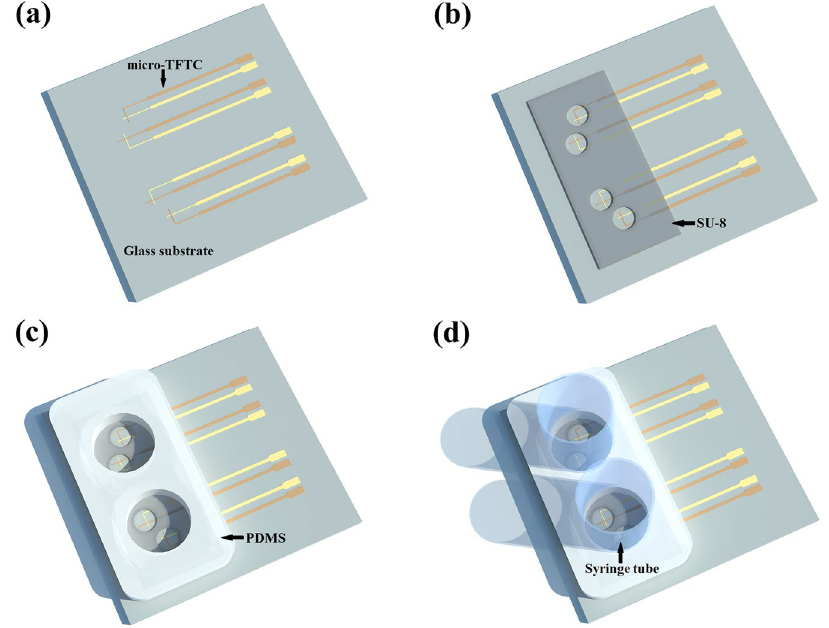
Figure 1. An illustration for the 3D structures of a testing device. ( a ) A micro-thin-film thermocouple (TFTC) array is fabricated on the glass substrate. ( b ) Testing Zones are confined by a layer of SU-8 above the micro- TFTC array. ( c ) Cylindroid rooms are confined by a layer of PDMS above the Testing Zones. ( d ) Syringe tubes are mounted to the PDMS layer at the holes’